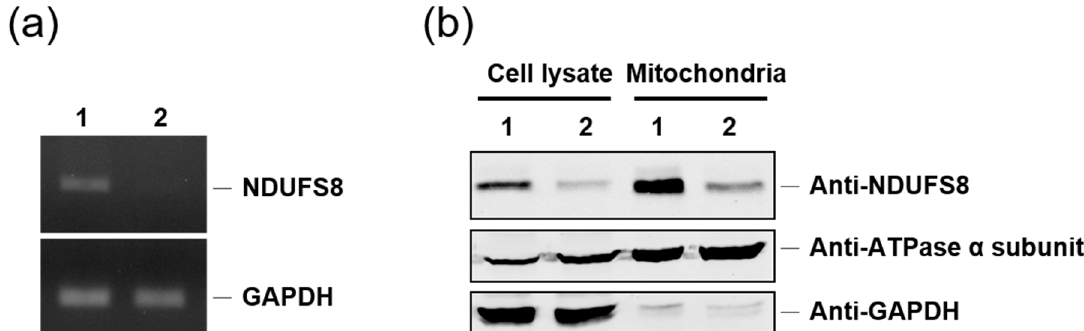
Figure 5. The successful knockdown of NDUFS8 gene expression by RNA interference on shRNA-C3 cells was observed both at the mRNA and protein levels. ( a ) The NDUFS8 expression level in T-REx293 and NDUFS8 knockdown cell line shRNA-C3 was determined by RT-PCR. ( b ) The protein level in T-Rex-293 and NDUFS8 knockdown cell line shRNA-C3 was determined on the total cell lysate and the mitochondrial fraction by immunoblotting analysis with anti-NDUFS8 antibody. GAPDH was used as an endogenous control in RT-PCR analysis and as a cytosolic marker in immunoblotting analysis; ATPase α subunit was used as a mitochondrial marker. 1, wild-type T-REx293; 2, NDUFS8 knockdown cell line shRNA-C3.